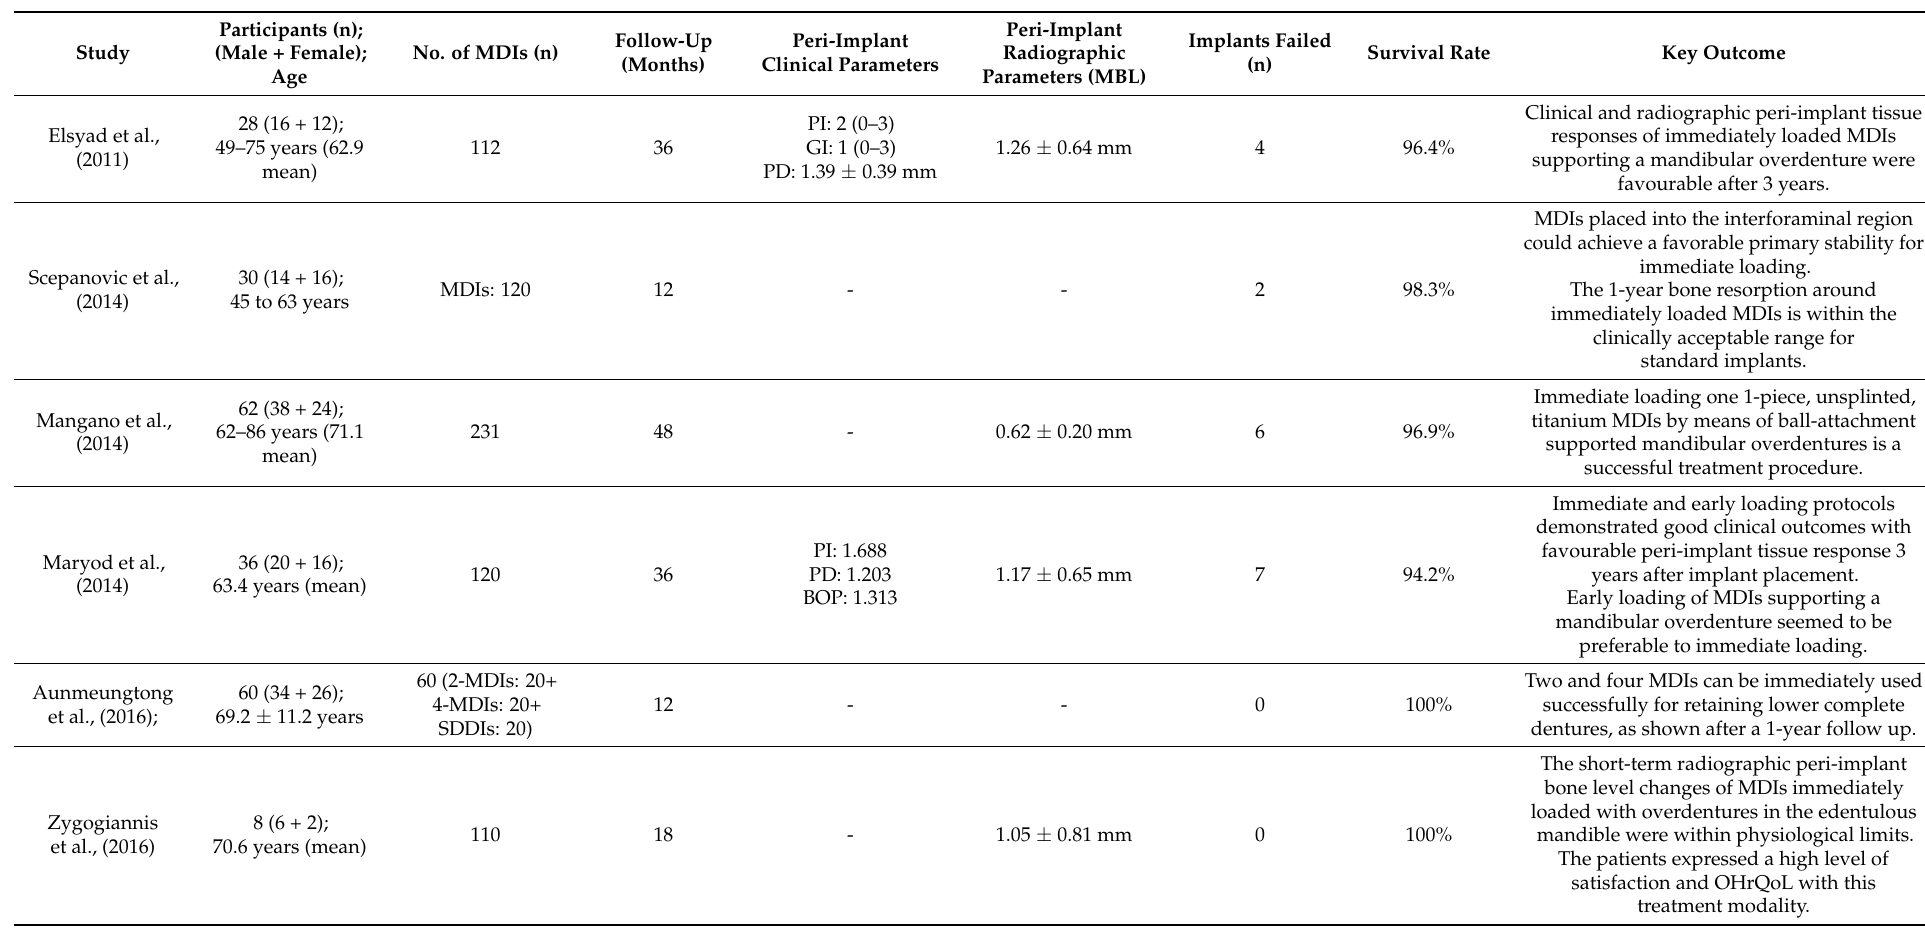
Table 2. Summary of quantitative data of the 11 included articles on immediately loaded mini dental implants to retain mandibular